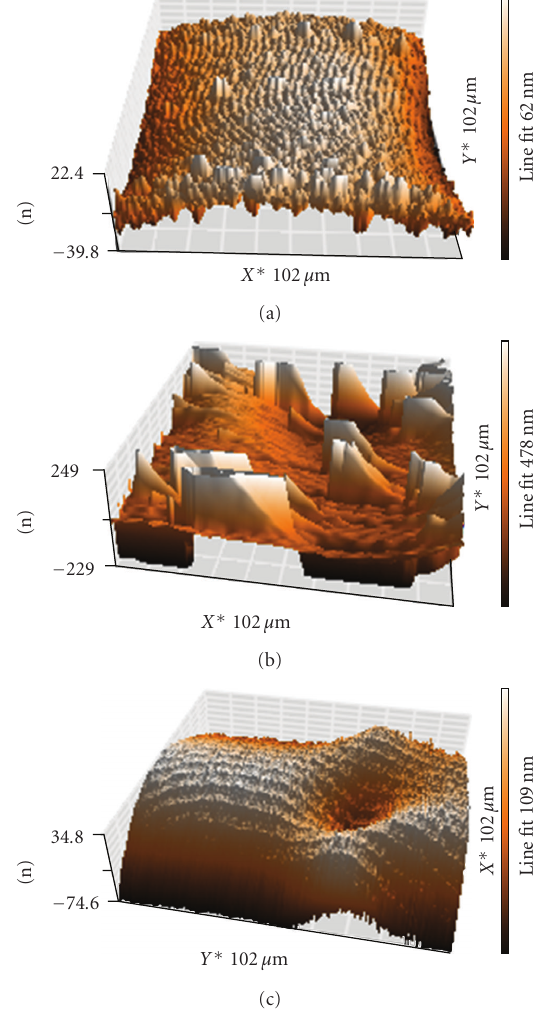
Figure 5: AFM topography of (a) polished copper surface without any treatment, (b) solution-treated surface without inhibitor in 0.5- M HCl, and (c) with 10-mM ATA in 0.5-MHCl.